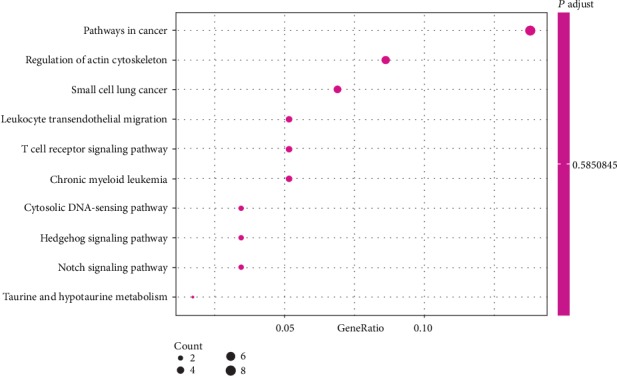
The dotplot picture of the top 10 enrichment KEGG categories. Note: each point in the figure represents a KEGG pathway, whose name is shown in the left coordinate axis. The abscissa is the GeneRatio, indicating the ratio of the genes annotated into the pathway in 58 genes and that of the species genes annotated into the pathway.